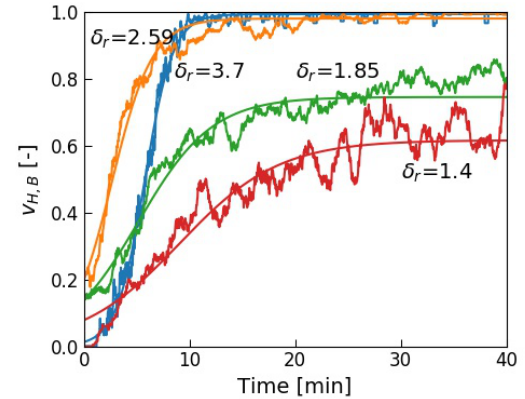
Fig. 2. Evolution of the volume fraction of the heavy component in the bottom layer of the cell for four different density ratios. Their fitting is done with a hyperbolic tangent function.